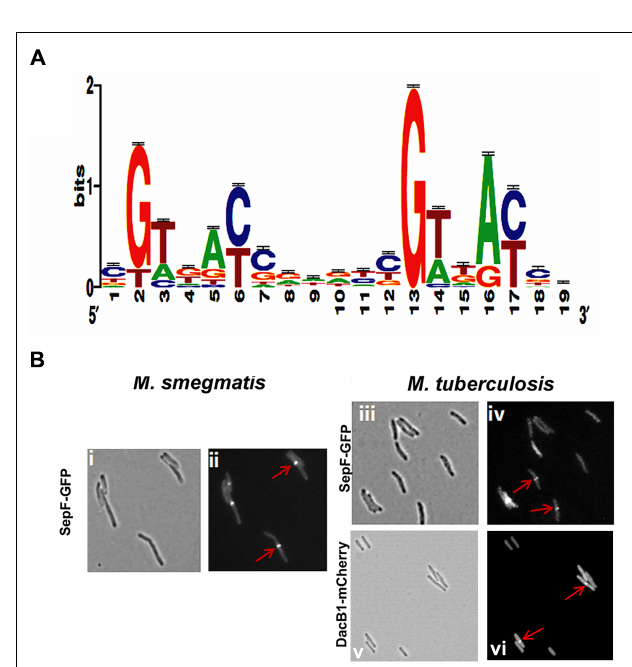
FIGURE 2 | MtrA motif and validation of DacB1 and SepF septasomal association: (A) MtrA logo determined by analyzing the MtrA regulon ChIP-Seq peaks. The p -value of the deduced motif is 2.6e-123, and the motif is a direct repeat of 9 nucleotides with a spacing of 2 nucleotides, starting with either G or T and possessing a sequence significantly similar to the previously defined MtrA-motif based on DNase I footprinting of ori C and Pfbp B targets (Rajagopalan et al., 2010), as well as to that of the MtrA-motifs of C. glutamicum and TB database (Brocker et al., 2011; Galagan et al., 2013), except for differences with respect to the weightings of the individual bases. (B) Localization of DacB1-mCherry in M. tuberculosis and SepF-GFP in M. smegmatis and M. tuberculosis . Bright-field (i,iii,v) and respective fluorescence (ii,iv,vi) images of and M. tuberculosis producing DacB1-mCherry and M. smegmatis and M. tuberculosis producing SepF-GFP are shown. Arrows denote septal